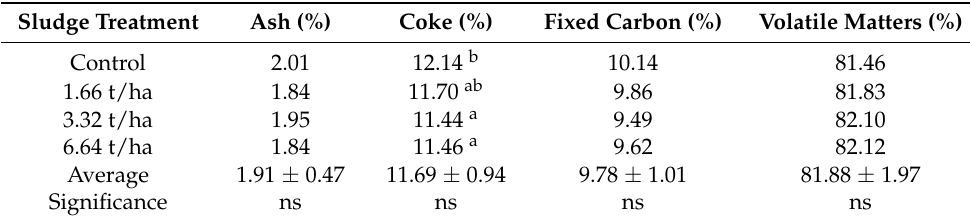
Table 4. Proximate analysis of Miscanthus biomass fertilized with different dosages of municipal sewage